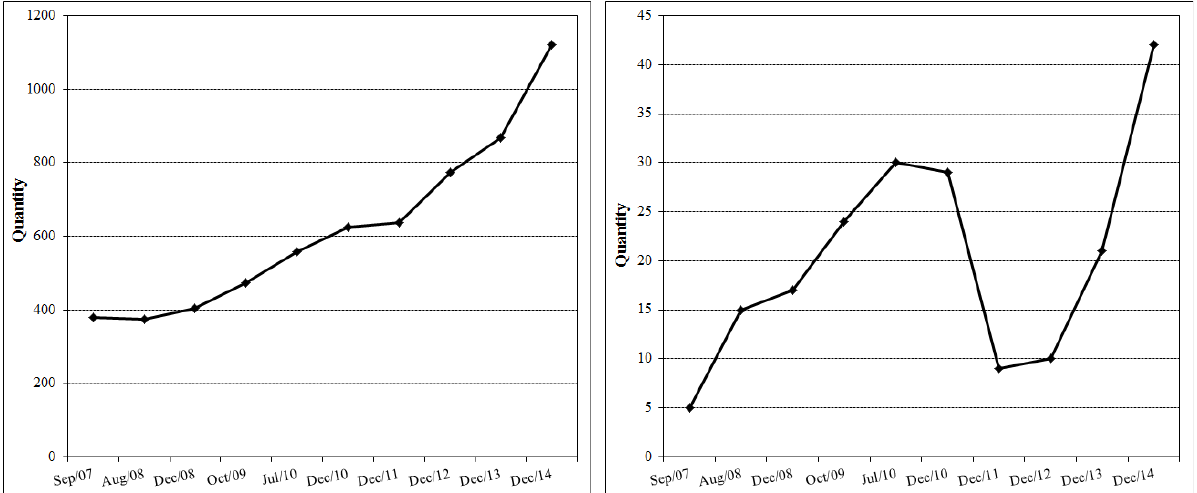
Figure 1. Time evolution of the total OHSMSs (Portugal). Figure 2. Time evolution (2007-2014) of the number of companies solely holding OHSMS certification (Portugal).